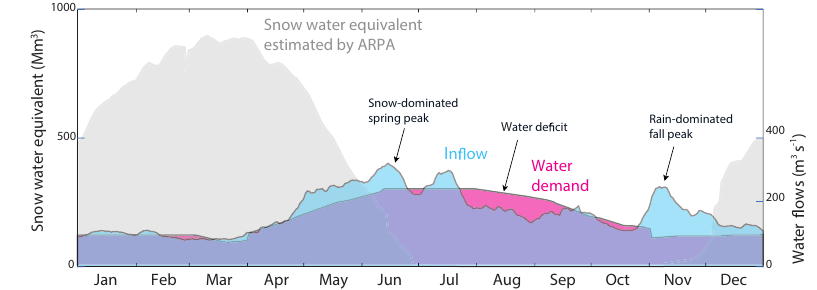
Figure 6. Hydro-meteorological regime of Lake Como.